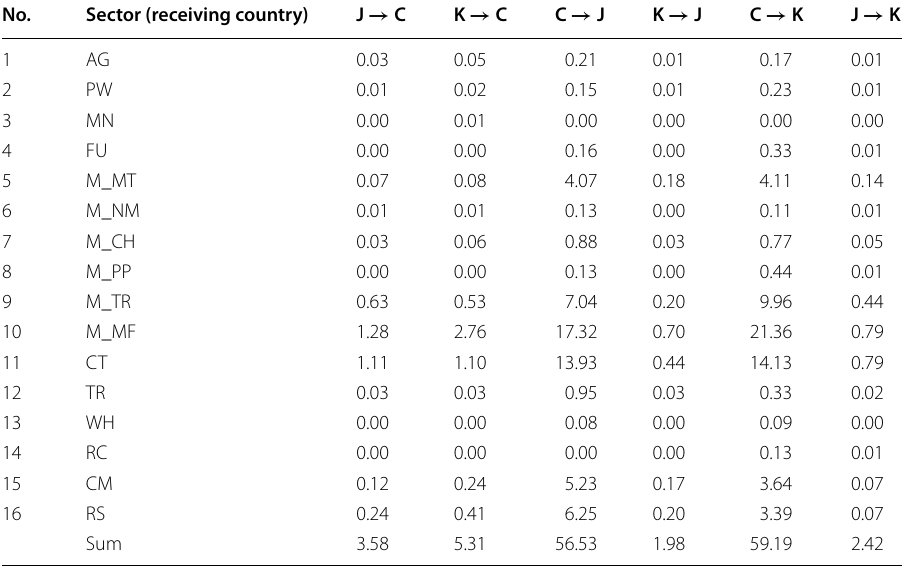
Table 9 Trans-boundary PM2.5 emission among China, Japan and Korea (in kt) No. Sector (receiving country) J →